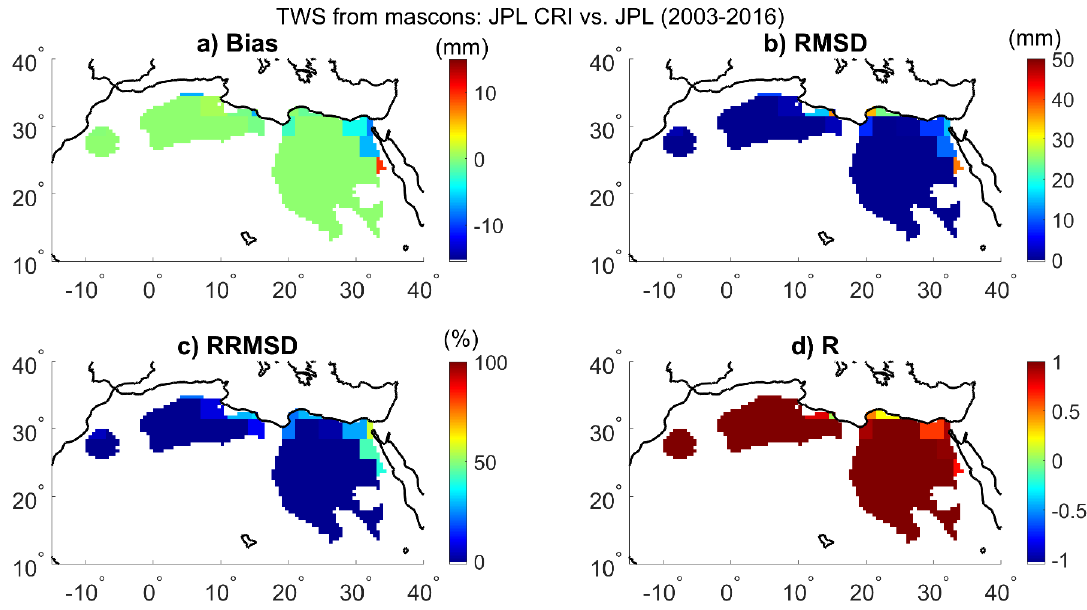
Figure A3. Maps of bias ( a ); RMSD ( b ) RRMSD ( c ); R ( d ) between TWS from CSR and JPL CRI mascon solutions over 2003–2016.